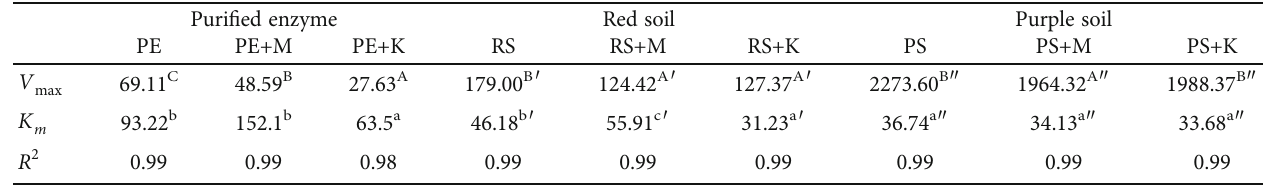
Table 3: Changes in the kinetic constants ( V and K m ) of LAP by montmorillonite and kaolinite with 10 μ mol L -1 Cd contamination. max Puri fi ed enzyme Red